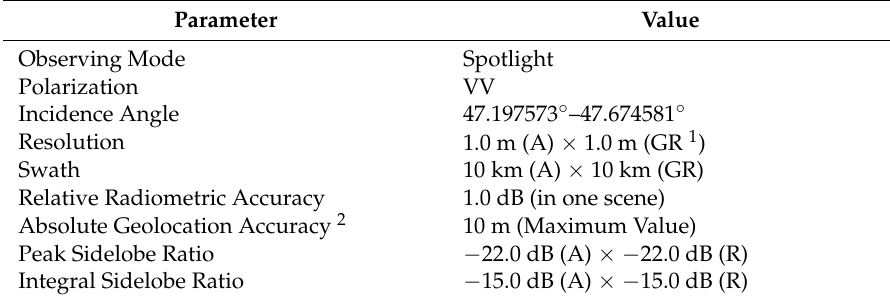
Table 2. Primary parameters for one performance test experiment of spotlight mode of GF-3.